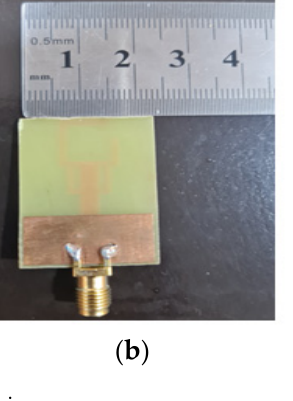
Figure 9. The fabricated antenna ( a ) front view ( b ) back view .